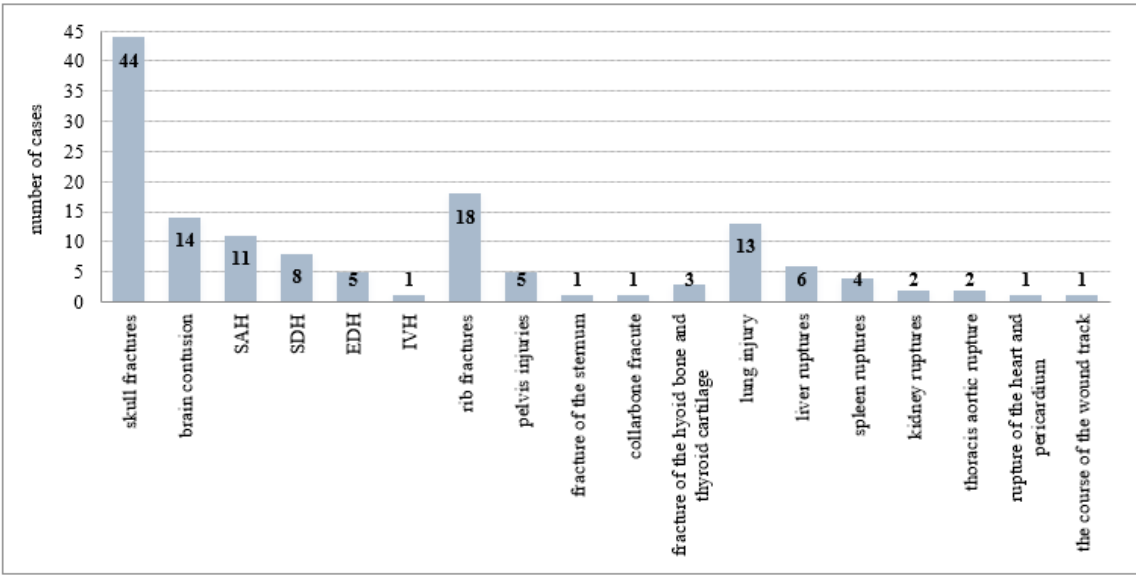
Figure 5. Total number of false negative CT scans in comparison with the autopsy. SAH—subarachnoid hemorrhage; SDH—subdural hemorrhage; EDH—epidural hemorrhage; IVH—intraventricular hemorrhage.